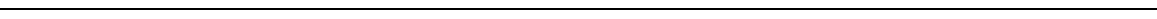
Fig.1 Cooperative role of BRAF V600E and TERT in the oncogenic behavior and tumor growth of cancer cells. Speci fi c shRNA against BRAF and siRNA against TERT were used to knock down BRAF and TERT in the indicated cancer cells, respectively, followed by performance of assays of MTT of cell proliferation ( a ), transwell cell migration ( b ), cell invasion ( c ), and colony formation in soft agar ( d ) (with representative images shown in the left panel and the average colony numbers in the right panel). Western blotting analysis of TERT and phosphorylation of ERK (p-ERK) was performed for K1 cells ( e ), from which xenograft tumors were derived to test the role of TERT and BRAF V600E in tumor development and growth ( f , g ). Panel f shows the time course of tumor growth and panel g shows the weights of tumors surgically excised. The “ Control ” in a − d represented the combination of scramble shRNA and Control siRNA. The “ Control ” in e − g represented the combination of scramble shRNA and DMSO. The horizontal bar in panels b and c represents 100 μ m. The red horizontal bar on the left of panel d represents 100 μ m; colonies larger than this size were counted and colony numbers are shown on the right of the panel. Little vertical bars in a , d , f, and g represent standard deviation (SD). * P < 0.05, ** P < 0.01, *** P < 0.001, by two-tailed Student ’ s t test. In panel a , the P values are for the comparison of the indicated condition with “ BRAF/TERT knockdown (KD) ” (red line). In panel f , the P values are for the comparison of the indicated condition with “ PLX4032/shTERT ” (red